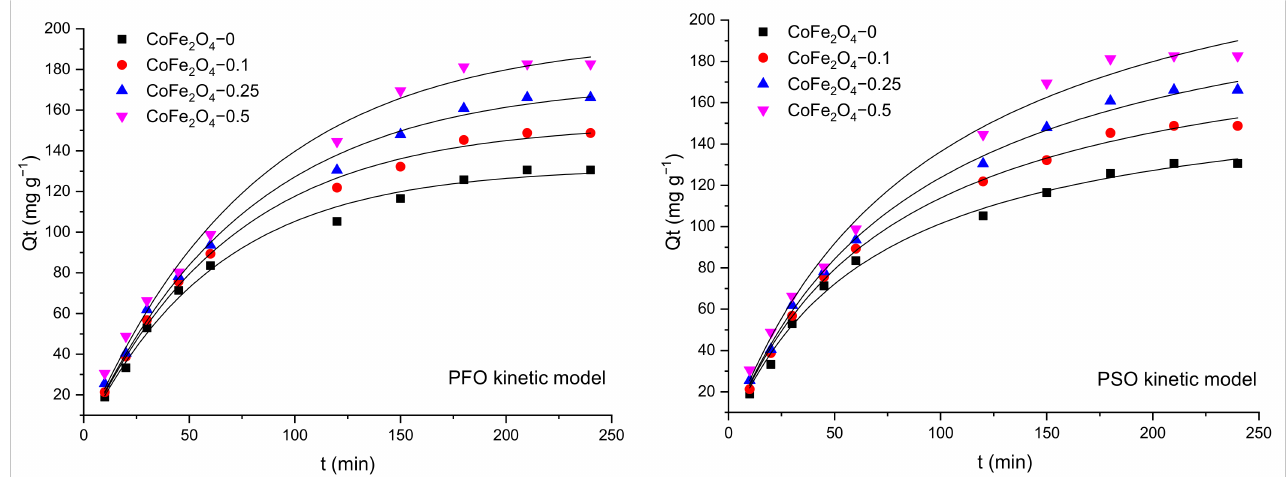
Figure 13. Graphical representation of the PFO and PSO kinetic models for removal of CR by adsorption onto CoFe 2 O 4 samples from single solutions (nonlinear regression).